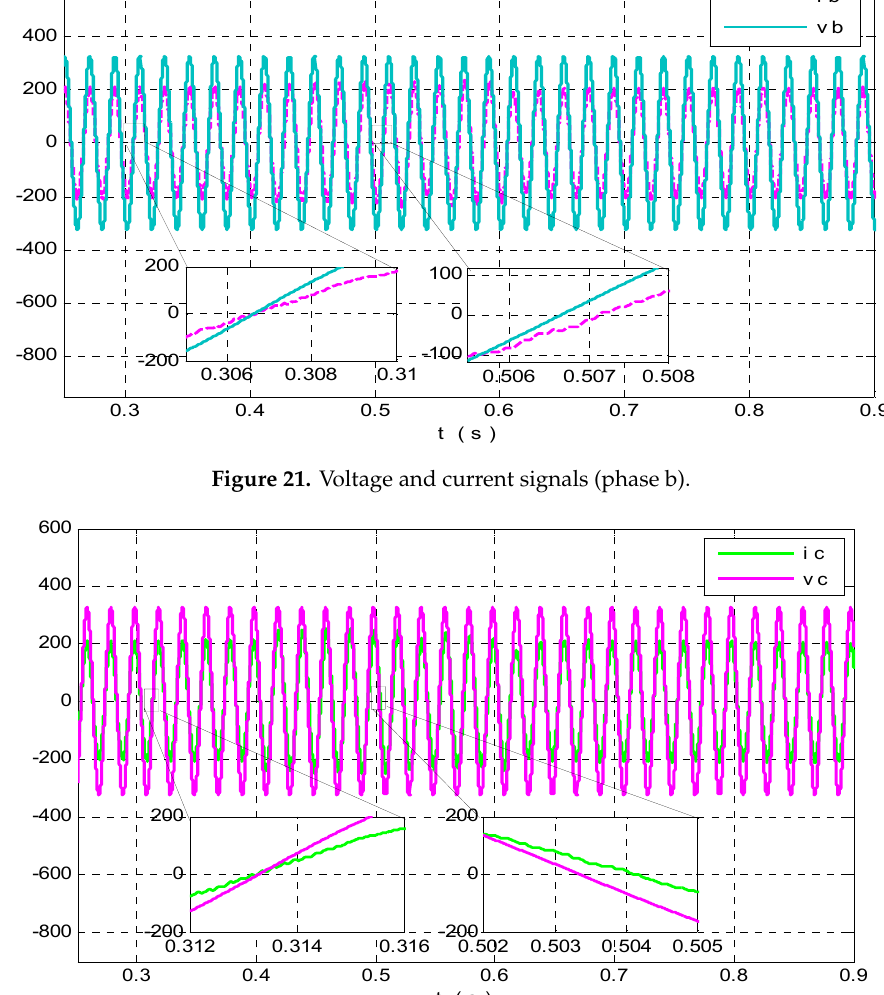
Figure 22. Voltage and current signals (phase c).